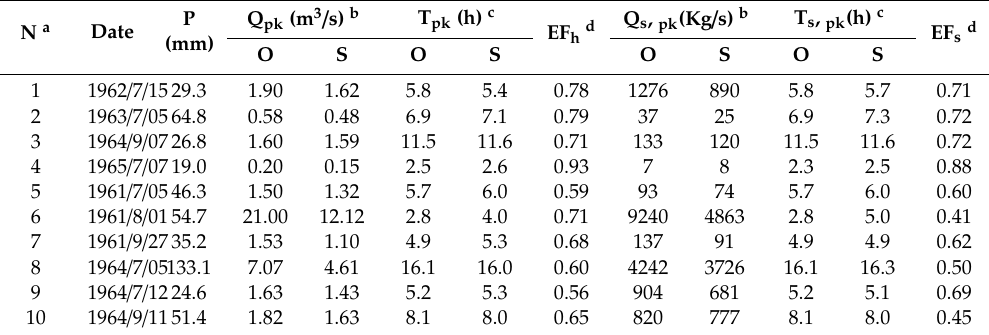
Table 6. Comparisons of observed versus simulated results for 10 rainfall-runo ff events in the first simulation stage.